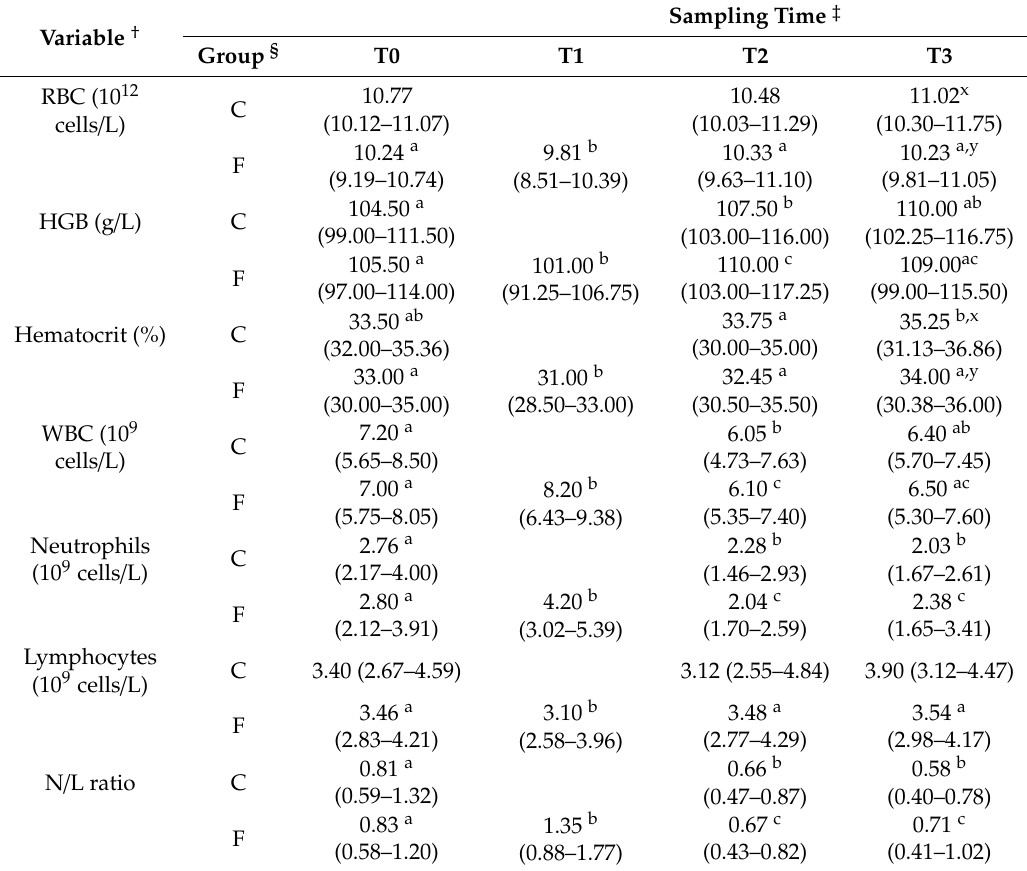
Table 1. Hematological parameters (median value and 25th and 75th percentile values) of fattening lambs at di ff erent blood sampling times throughout the fattening